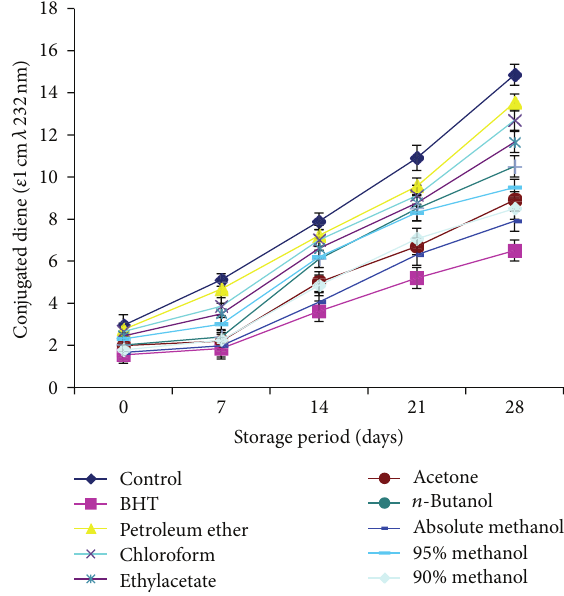
Figure 3: Peroxide values of sunflower oil stabilized with C. vimi- nalis leaves extracts.